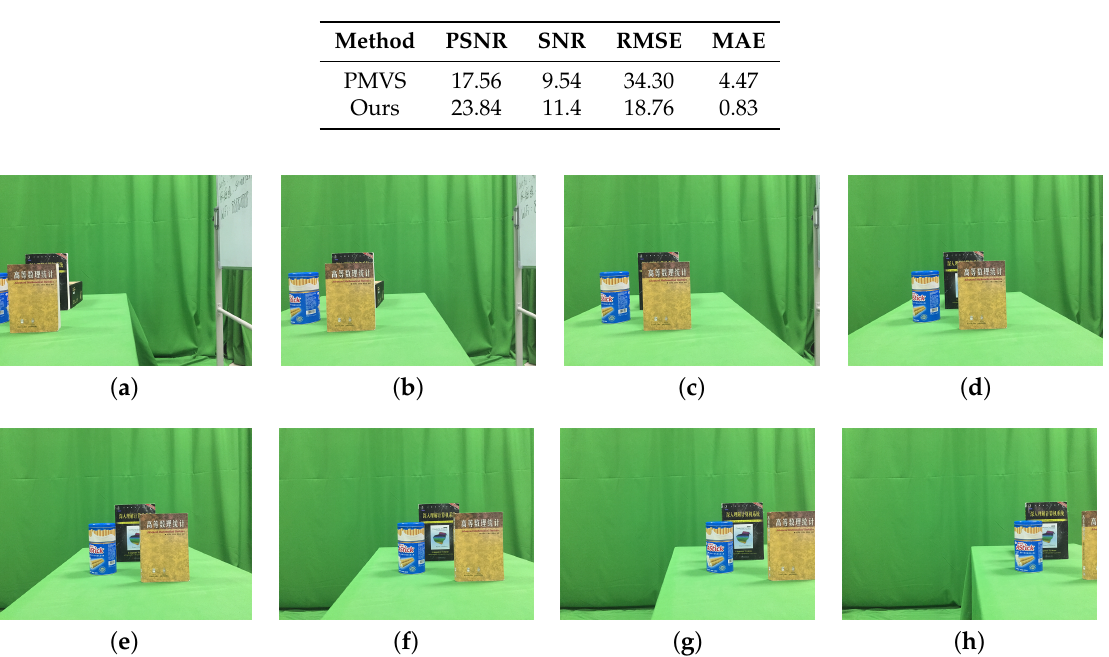
Figure A1. Examples of the input images in the second book scene. ( a – h ) are captured images by camera array in the same scene.